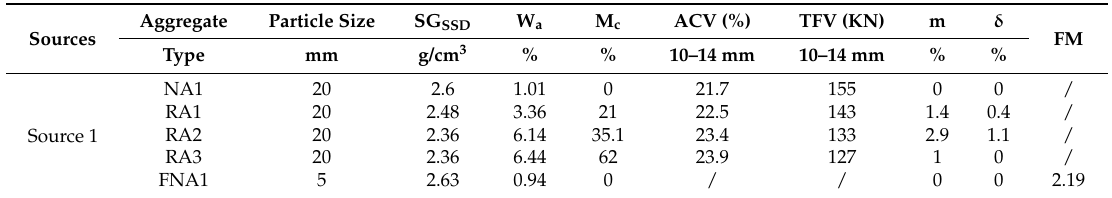
Table 1. Properties of